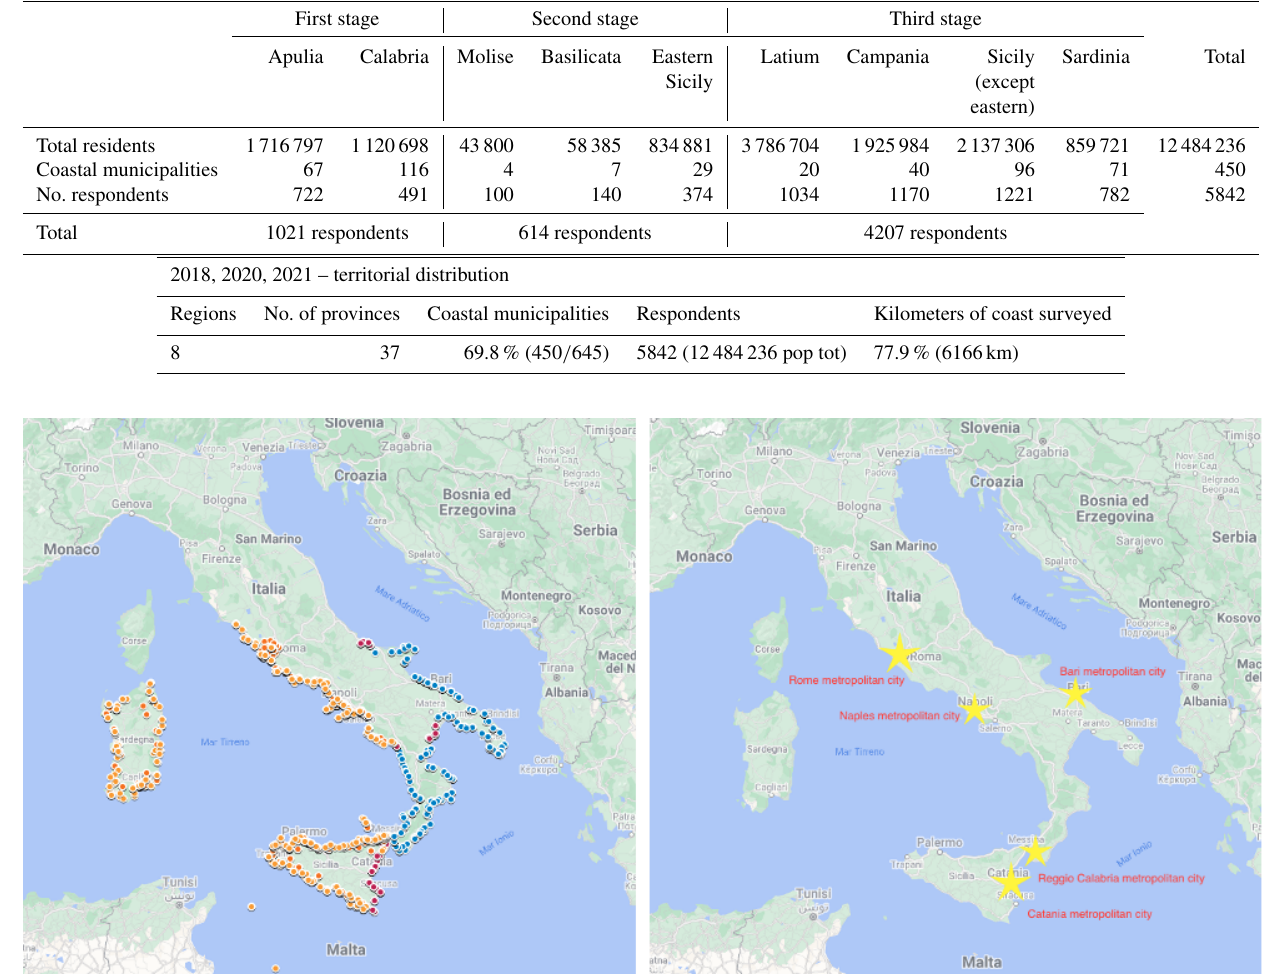
Figure 1. Maps of the CATI interview distribution (left) and coastal metropolitan cities (right). The differently colored circles, on the left map, indicate the interview distribution in the different survey phases: blue shows the interviews in the first survey phase (2018); red shows the second survey phase (2020); orange shows the distribution of interviews in the third survey phase (2021). Yellow stars, on the right map, indicate metropolitan cities (provincial capitals) where population density is high for a wide territorial area. Map data modified from © Google Maps